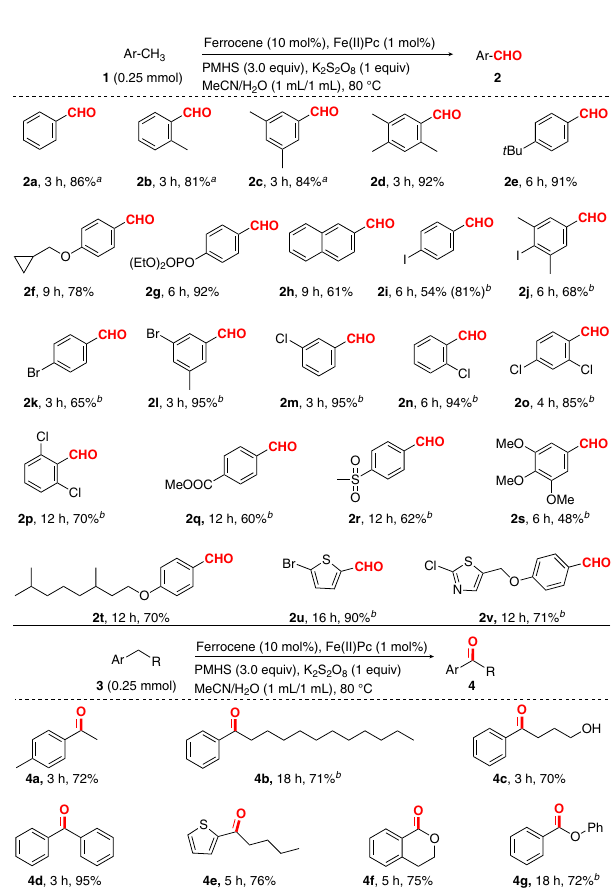
Fig. 2 Iron-catalyzed oxidations of methyl aromatics and other alkyl aromatics. The substrate scope of methyl aromatics and other alkyl aromatics. Reaction conditions: substrate 1 or 3 (0.25mmol), ferrocene (10mol%), Fe(II) phthalocyanine (1mol%), K 2 S 2 O 8 (0.25mmol), PMHS (0.75mmol), CH 3 CN/H 2 O (1:1, 2.0mL), 80°C, and air; Yields of the isolated products are given. a Based on 1 H NMR analysis on the crude reaction mixture with chlorobenzene as the internal standard. b K 2 S 2 O 8 (0.75mmol) NATURE COMMUNICATIONS| (2019) 10:2425